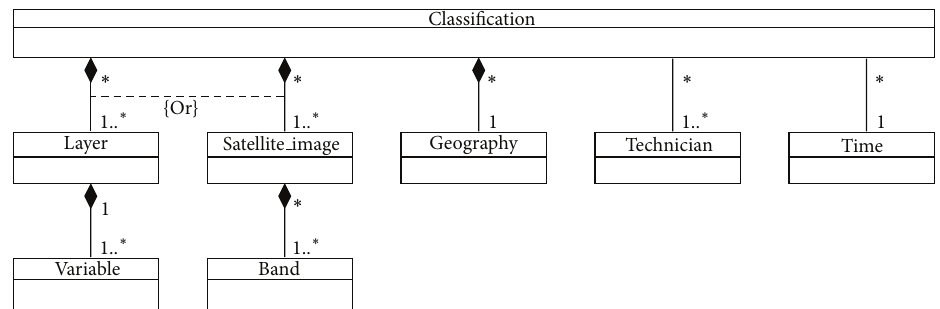
Figure 4: Ontology of the EID metadata that traders use.